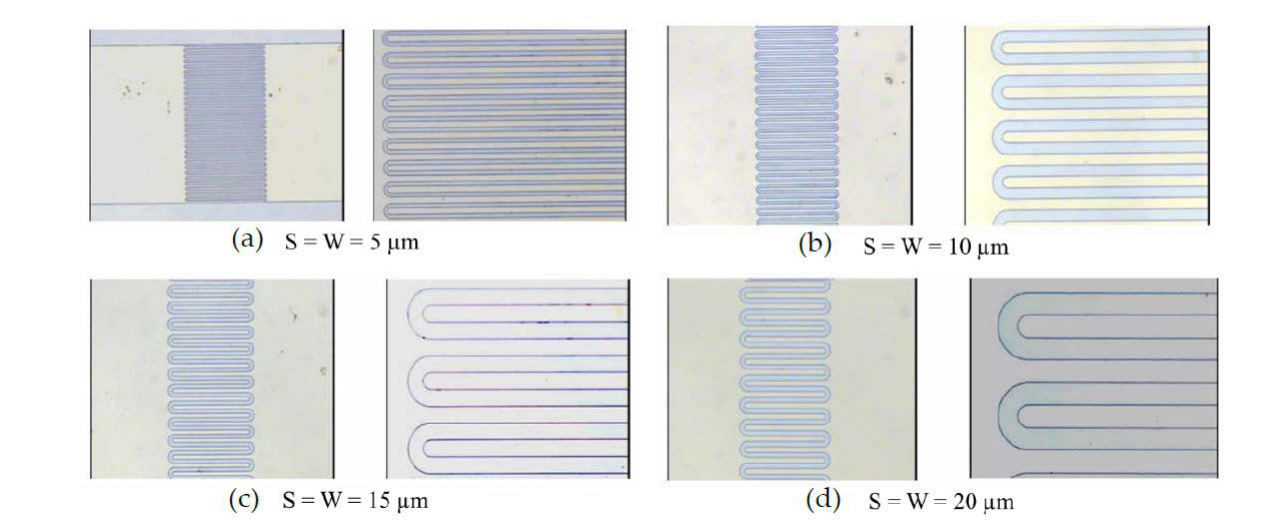
Figure 2. The sizes are ( a ) 5, ( b ) 10, ( c ) 15, and ( d ) 20 µm for the interdigital electrode spacing and width.